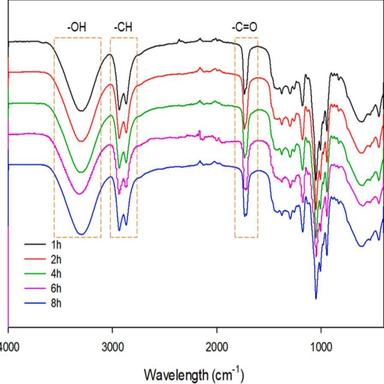
FT-IR spectra of PHB-diol samples obtained via transesterification at different reaction times.